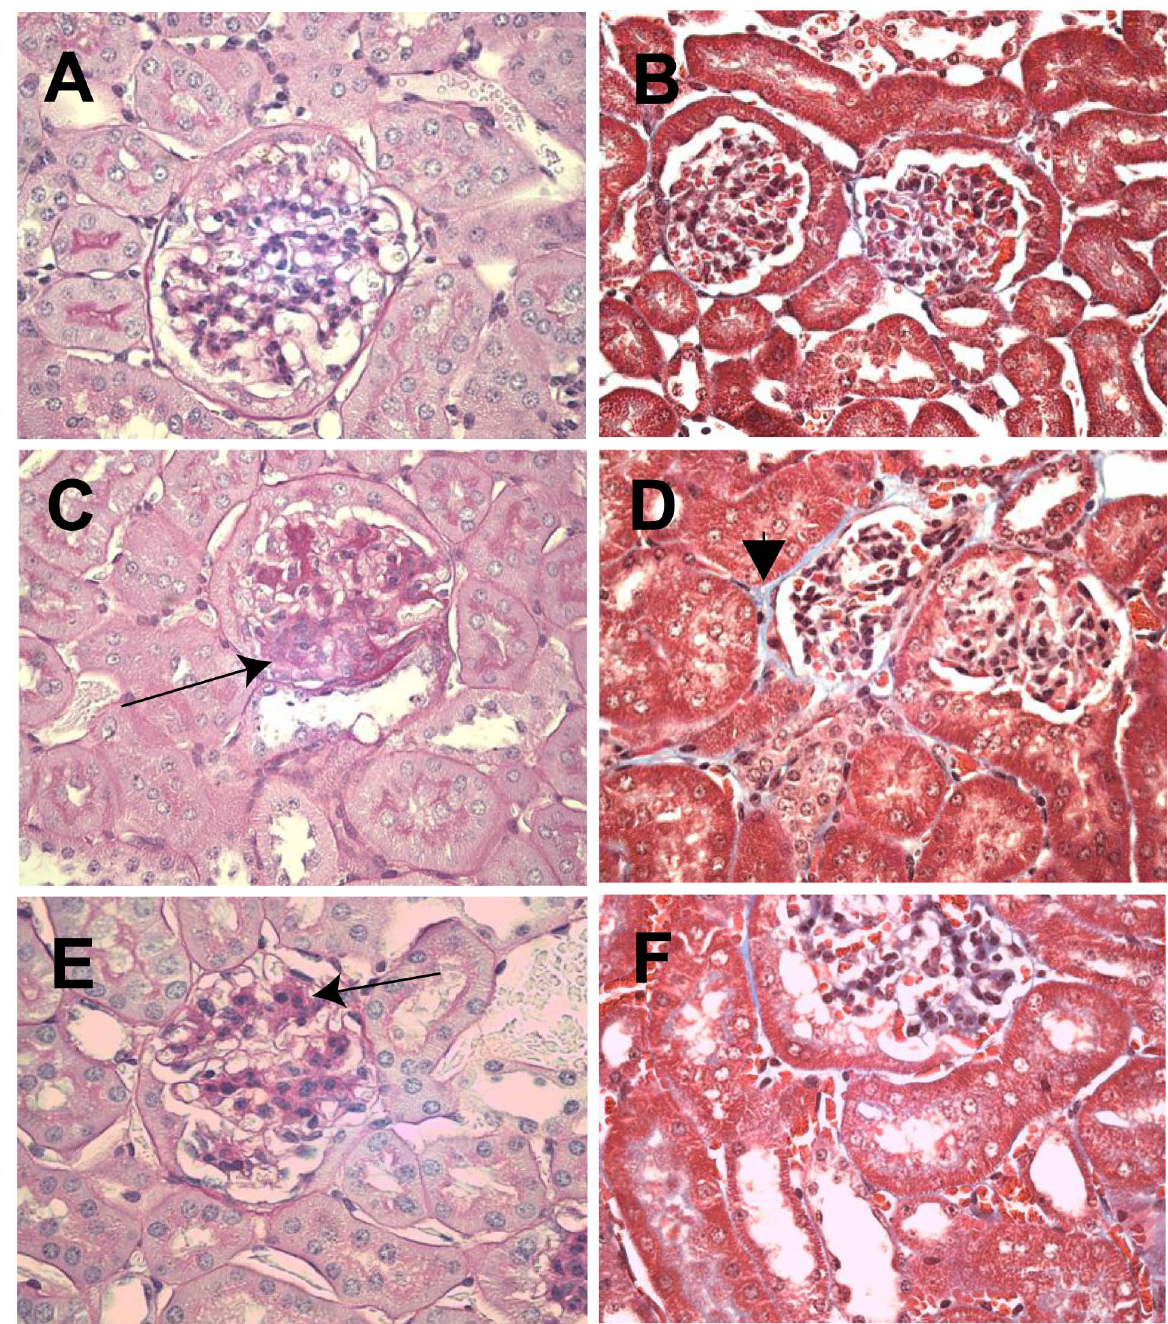
Figure 1. Representative renal histological findings from control FVB mice and from untreated and treated diabetic OVE26 mice. Shown are PAS- ( A, C, E ) and trichrome- ( B, D, F ) stained sections from control FVB mice ( A, B ) from vehicle-treated diabetic OVE26 mice ( C, D ), and from losartan-treated OVE26 mice ( E, F ). In contrast to non-diabetic mice which did nor show any renal pathology, diabetic mice displayed diffuse mesangial expansion ( C, E; arrow ). Tubulointerstitial fibrosis was not detectable at this stage of DM; however, trichrome blue stain was detected in the interstitial space in OVE26 mice (e.g., D, arrowhead ), suggesting early accumulation of extracellular matrix material. doi:10.1371/journal.pone.0096987.g001 in the diabetic state. The pseudogene resides , 125 kb ‘‘upstream’’ the DNAnexus analysis platform. Murine Gm6300 corresponds to RefSeq NR_033591.2 and had been assigned the following of Slc7a12 ( Figure 5A ), shares sequence homology with the latter (see below), and appears to have been derived from it. However, provisional description: ‘‘Mus musculus predicted gene 6300 there is only , 70–80% homology at the nucleotide level across the subset of expressed regions (inferred exons; data not shown) such representative of the richness of detail that can be achieved with that this is highly unlikely to represent an alignment artifact within